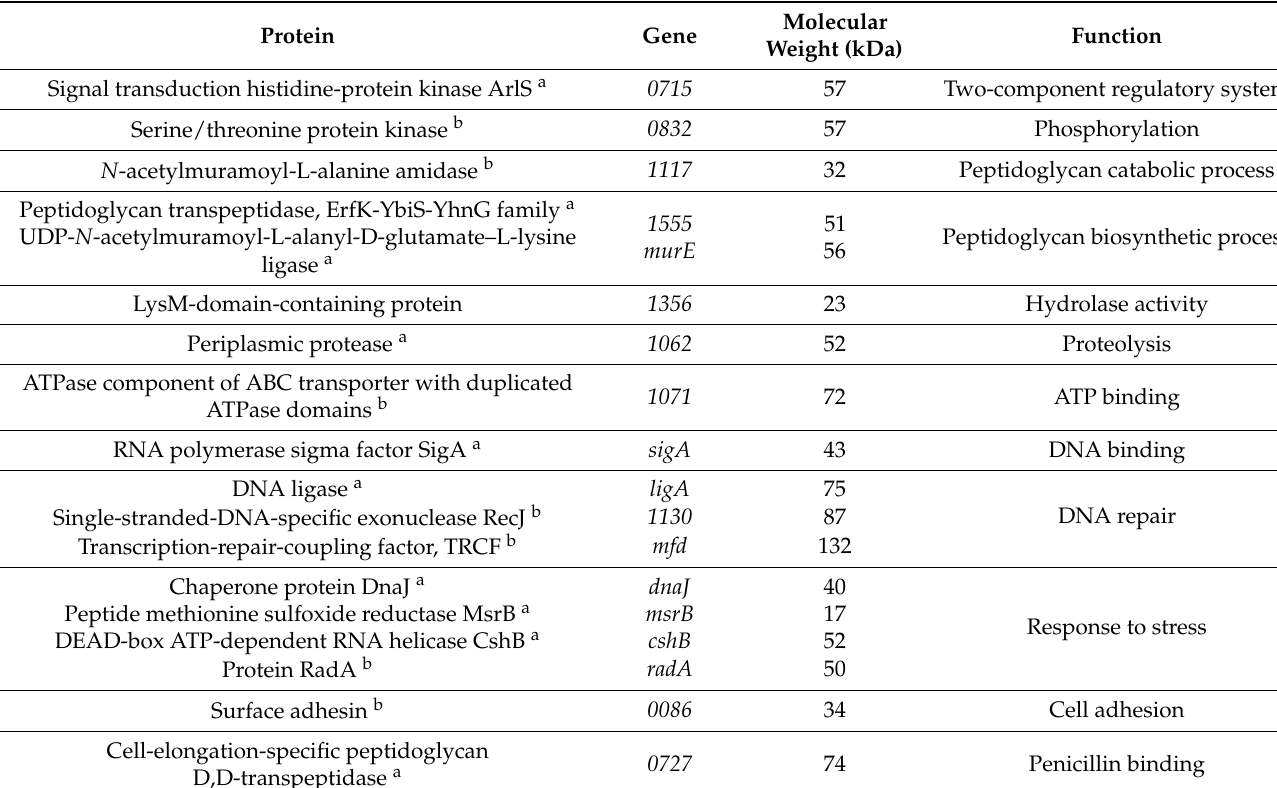
Table 6. List of the top 18 proteins involved in tolerance processes to gastrointestinal conditions in P. pentosaceus